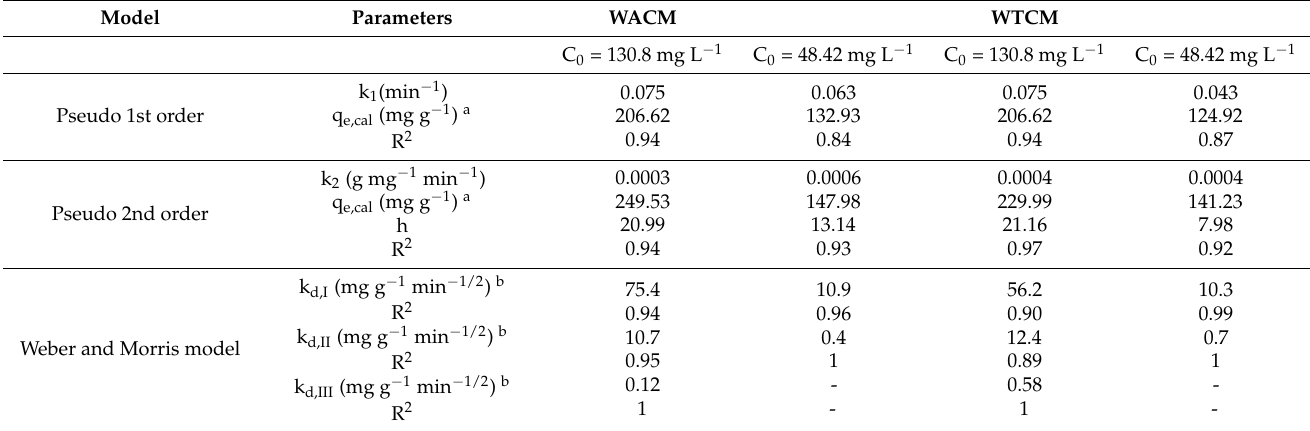
Table 4. Kinetic parameters of Pb(II) adsorption on WACM and WTCM